Question: Briefly state, in one sentence, what is plotted here.
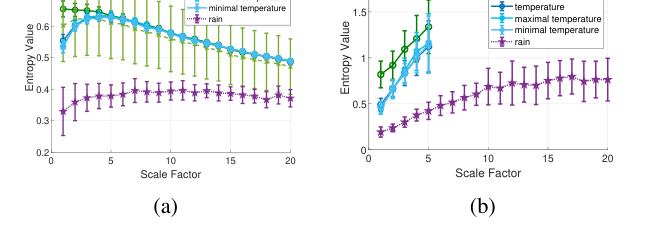
Answer: Comparison of entropy analysis of weather data with state-of-the-art methods: (a) Dispersion Entropy [27], (b) Sam- ple Entropy [4].